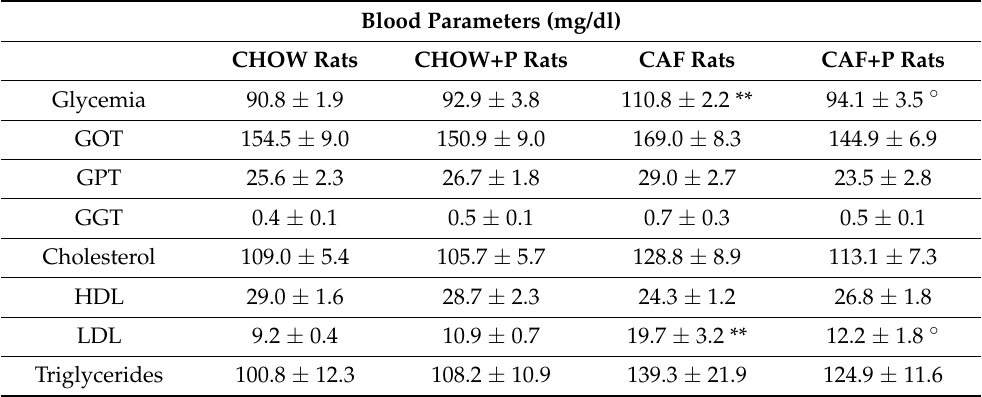
Table 1. Blood parameters levels at the end of the experiment (day 84).